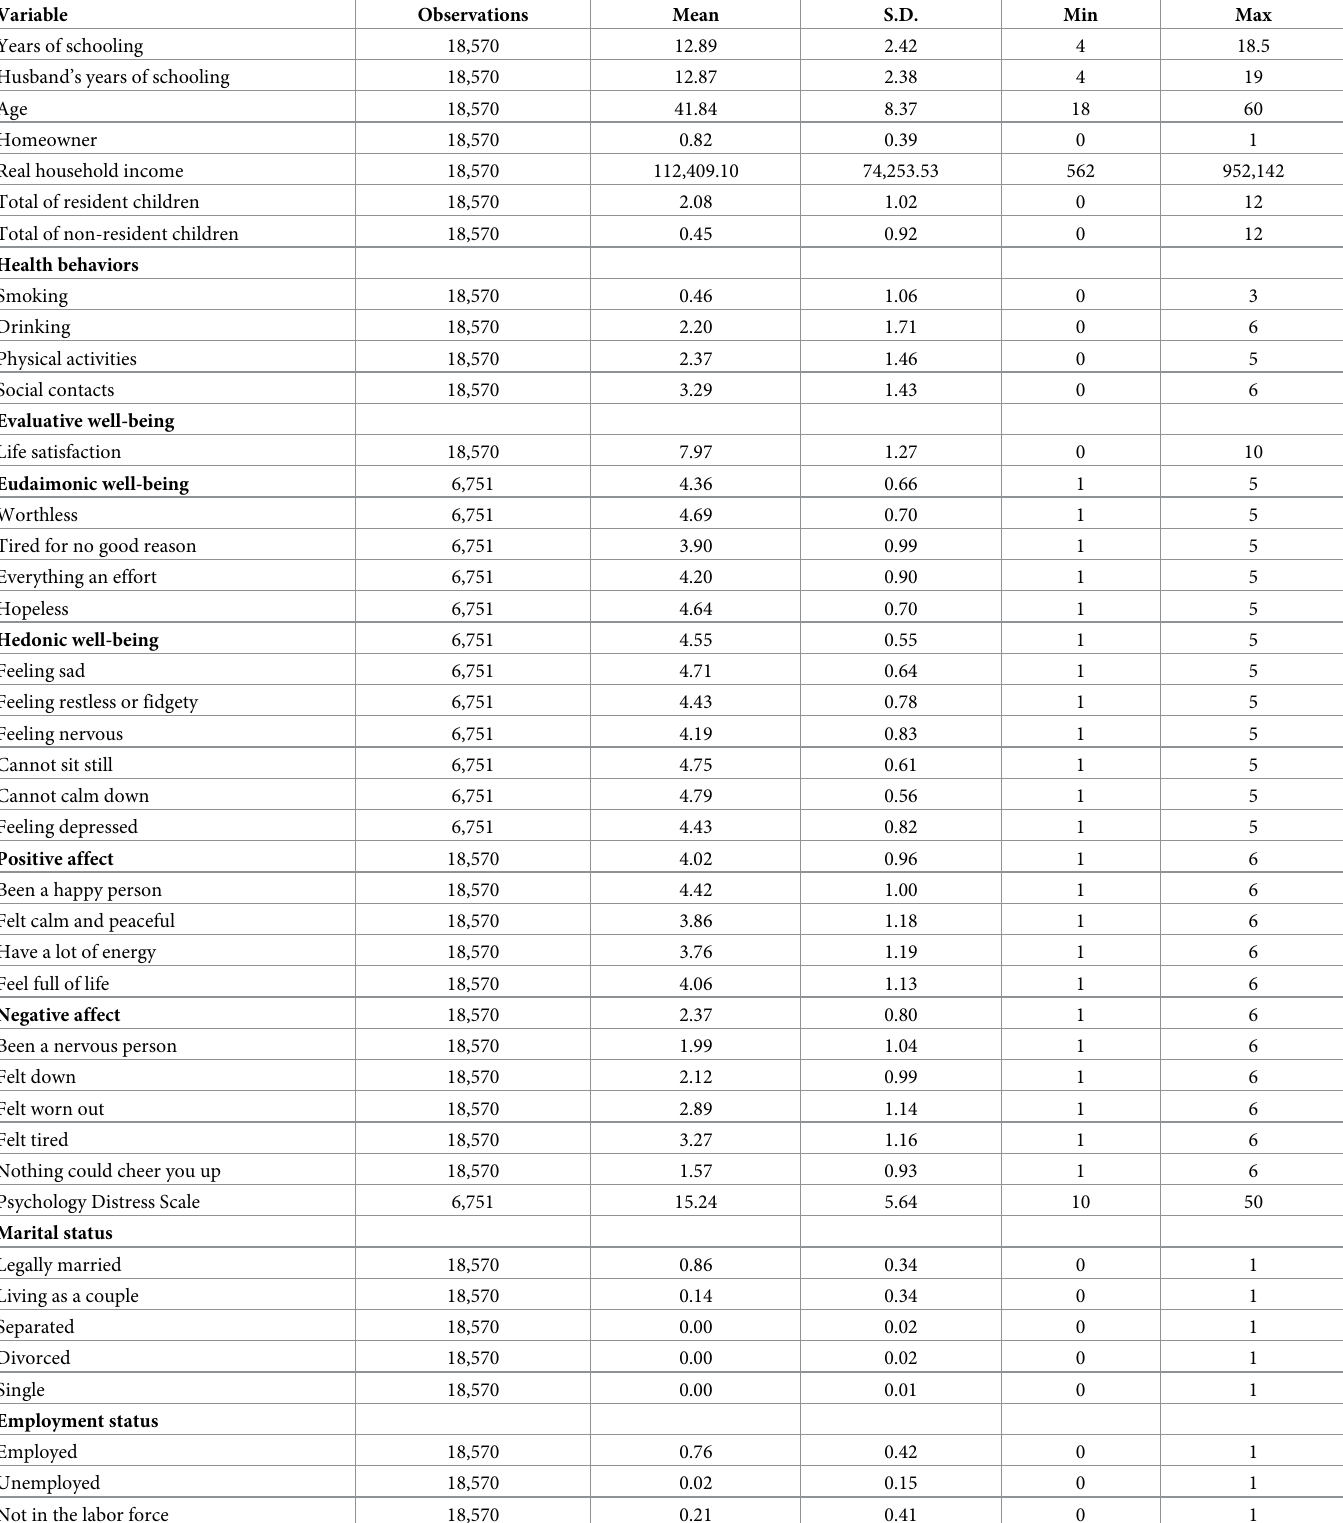
Table 1. Descriptive